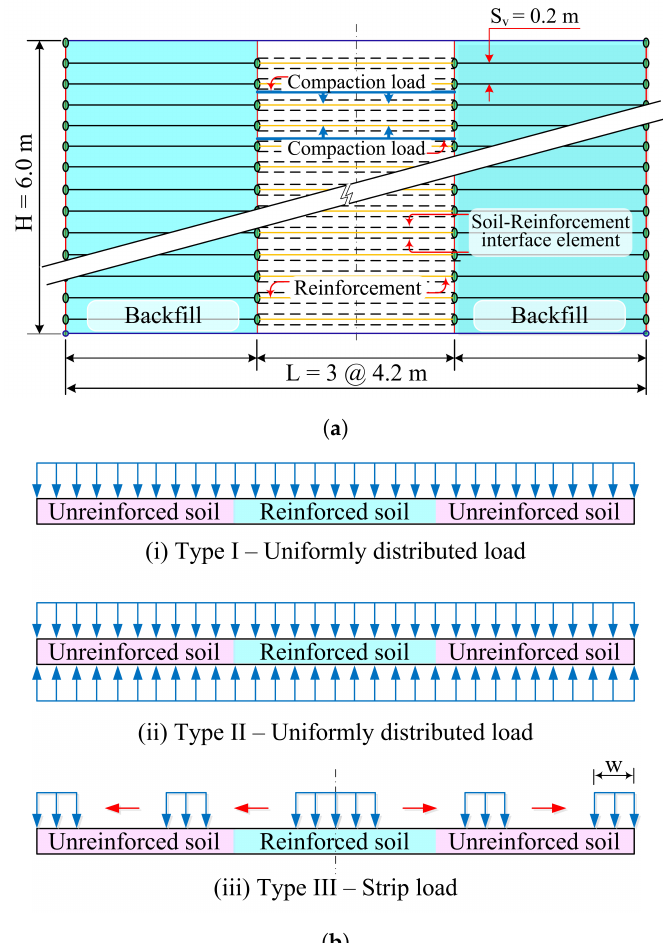
Figure 9. ( a ) Schematic diagram and configuration of the back-to-back Geo-synthetic Reinforced Soil (GRS) mass. ( b ) Heavy compaction procedures for GRS wall mass adopted in FE